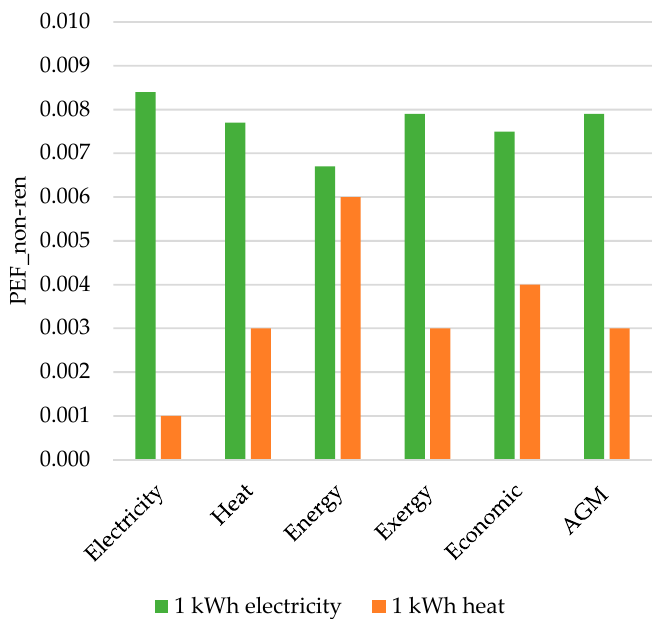
Figure 6. The non-renewable primary energy factor shows the sum of all non-renewable energy inputs (non-renewable biomass, nuclear, and fossil fuels) needed to produce 1 kWh of electricity or 1 kWh of heat. The results vary greatly depending on the allocation method used.